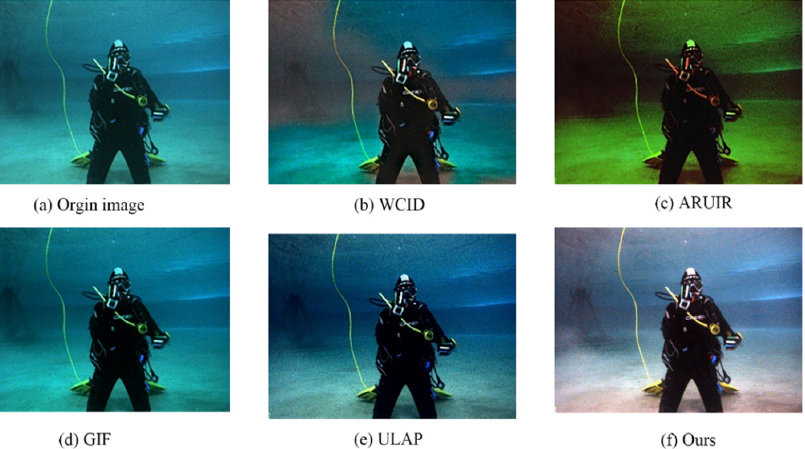
Figure 7. Underwater image enhancement result. ( a ) The origin image. ( b ) The result of WCID; ( c ) the result of ARUIR; ( d ) the result of GIF; ( e ) the result of ULAP; ( f ) the result of ours.